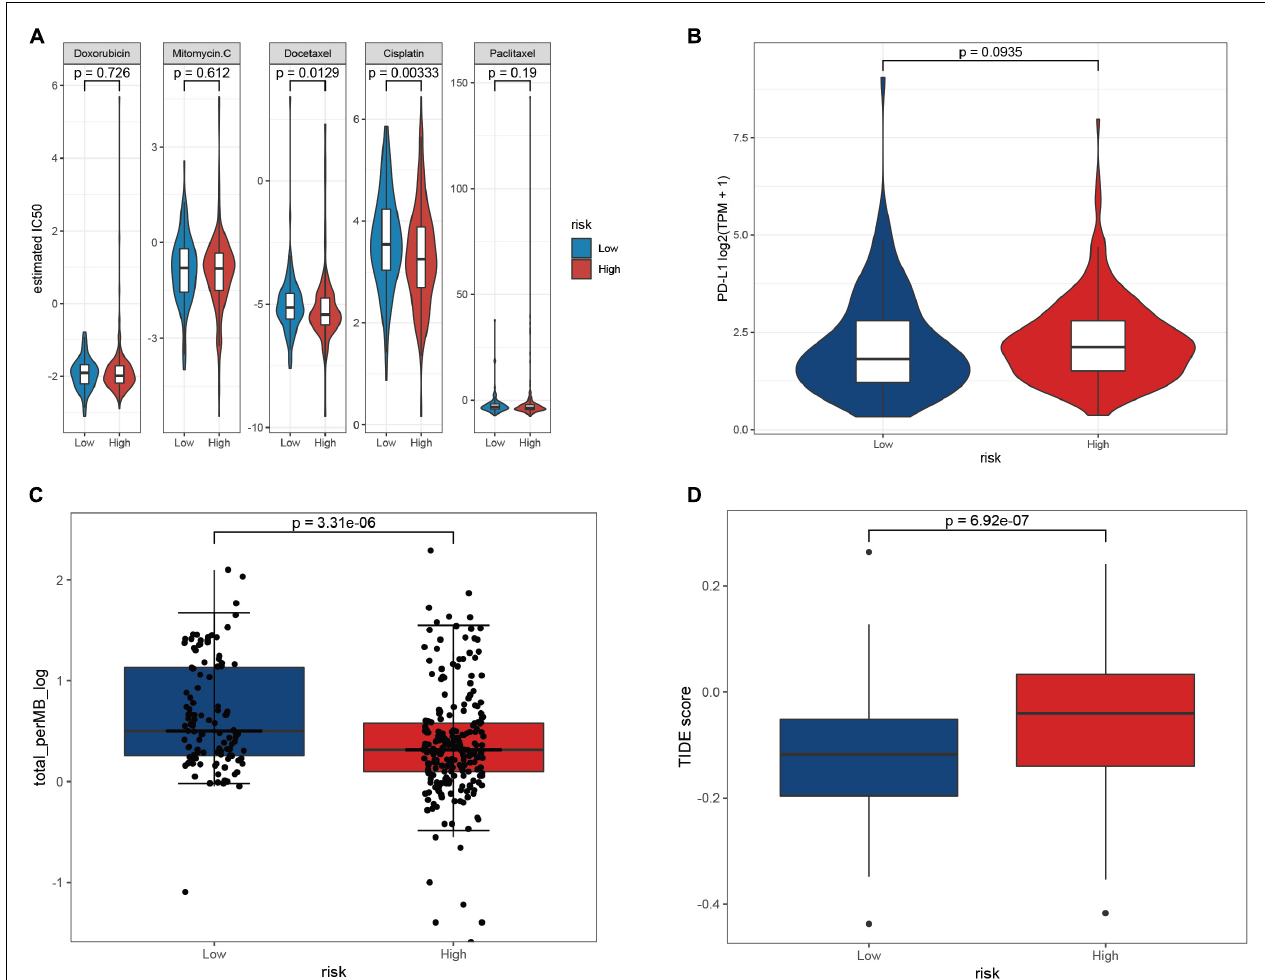
FIGURE 10 | Chemotherapy and immunotherapy sensitivity prediction. (A) The estimated IC50 for various chemotherapeutic drugs. (B–D) The differences of PD-L1 expression (B) , TMB (C) , and TIDE scores (D) between the low- and high-risk